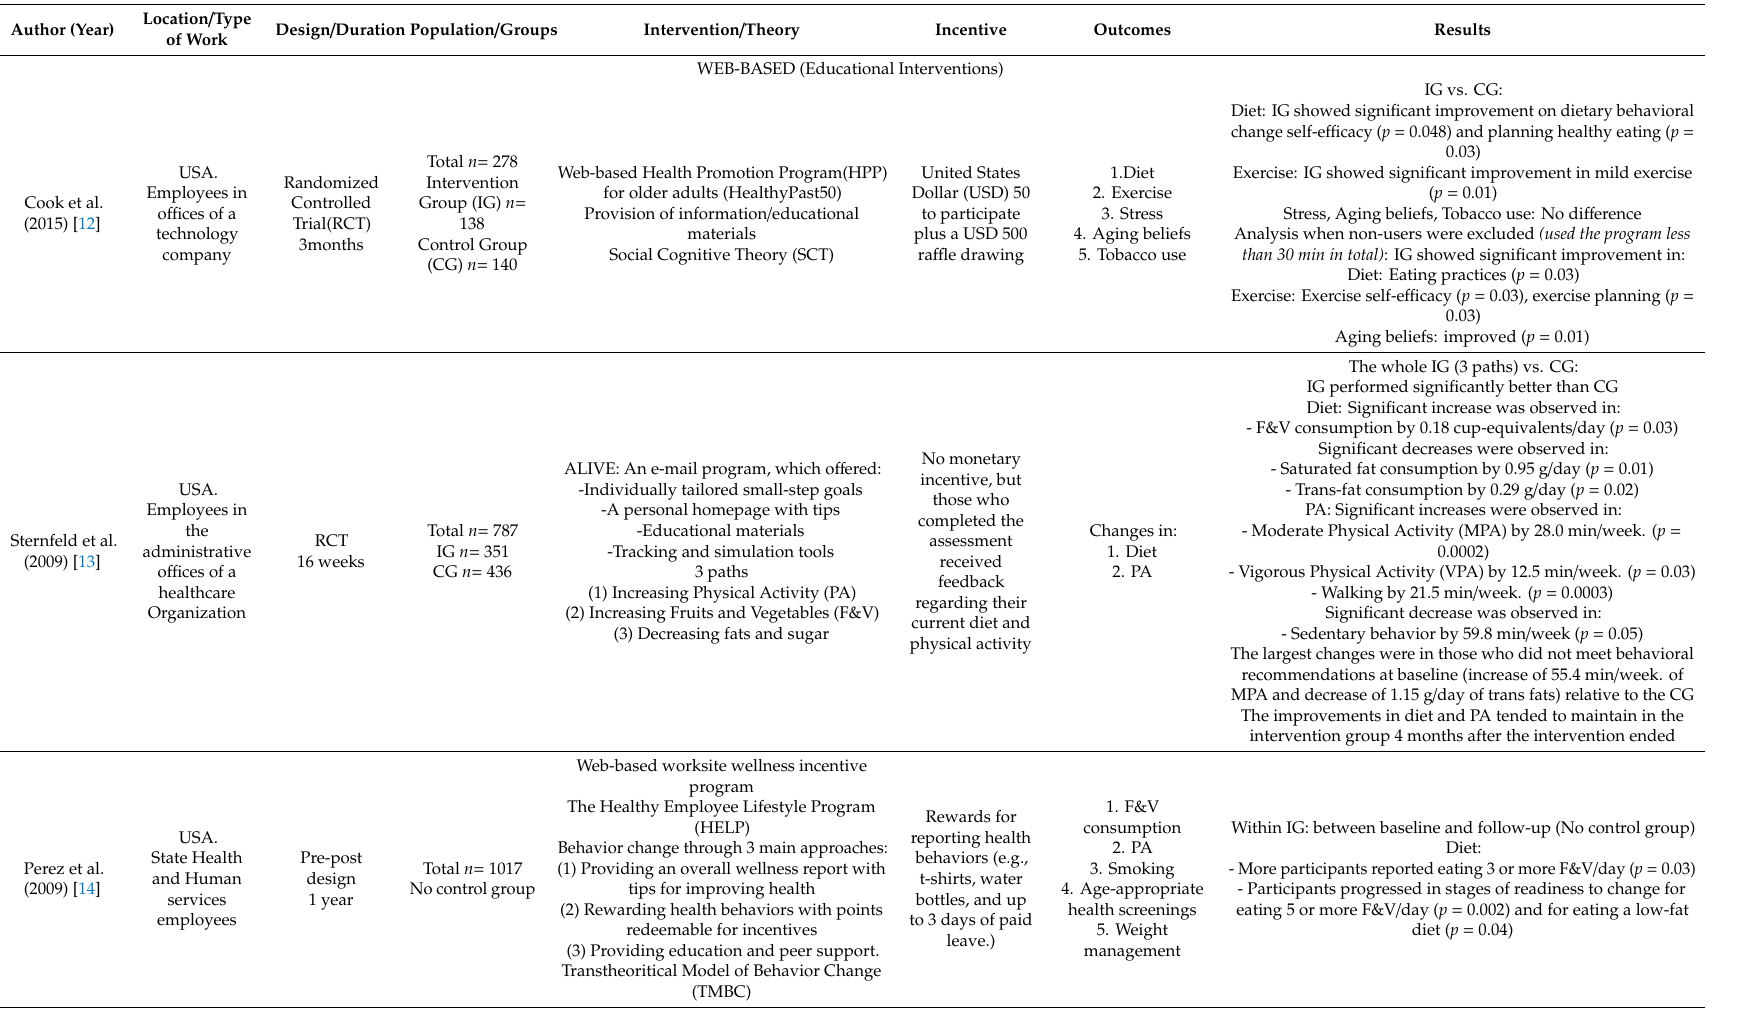
Table 1. Summary of the studies focusing on web-based interventions listed by author and year, the study design, duration, sample size, intervention type, intervention, incentive, outcome measures, and main